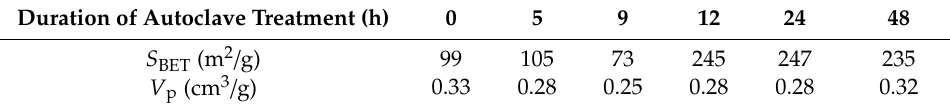
Table 3. Textural properties of binary M3 / SiO 2 90:10 mixed oxides.